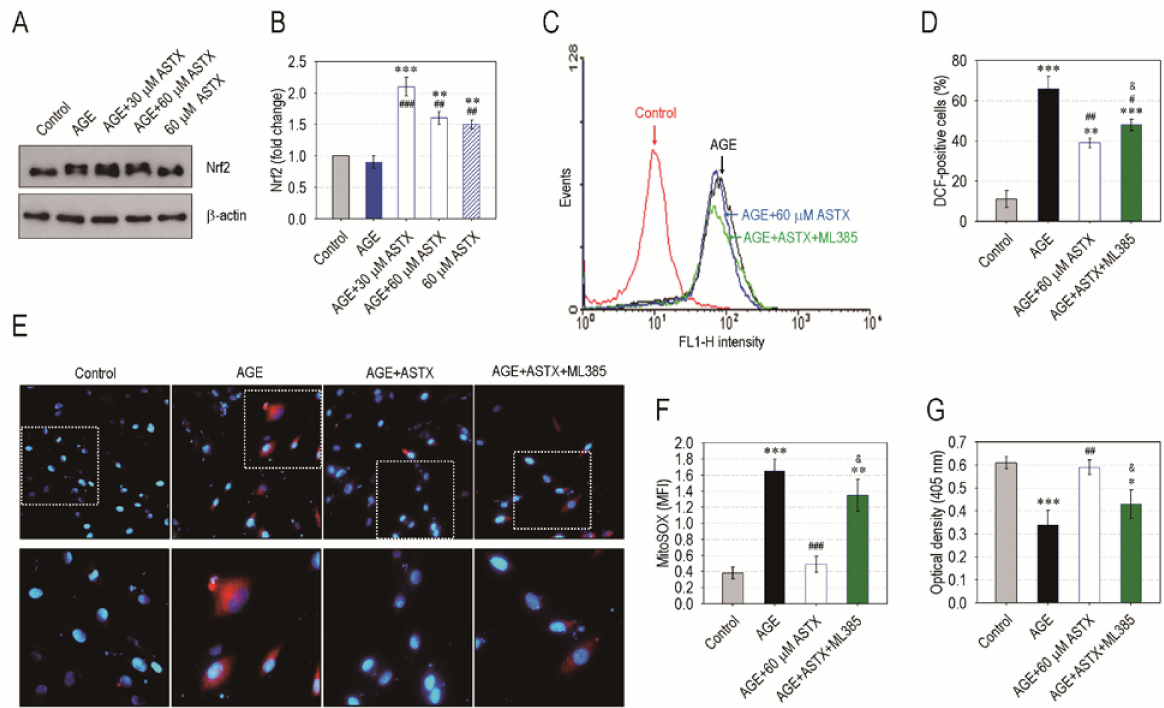
Figure 8. ASTX inhibits oxidative stress and increases proliferation in AGE-exposed hPDLCs by upregulating Nrf2 pathway. The hPDLCs were incubated in growth medium supplemented with and without AGE (200 µ g/mL), ASTX (30 or 60 µ M), or both. ( A ) After 48 h of incubation, the protein level of Nrf2 in the cells was determined by immunoblot assay, and ( B ) the Nrf2-specific band intensity (fold change to control) was calculated after normalizing its level to that of β -actin ( n = 4). The hPDLCs were also exposed to AGE, ASTX, or both with and without the pretreatment with 5 µ M ML385. After 48 h of incubation, ( C ) the DCF-specific signal and ( D ) the DCF-positive cells (%) in the hPDLCs were calculated by flow cytometry ( n = 5). After the same time, ( E ) immunofluorescence assay was also performed using MitoSOX Red and DAPI, and ( F ) the red dye-specific MFI among the experiments was compared after calculating the levels using ImageJ software ( n = 5). ( G ) In addition, proliferation rate of the cells was determined at the end of 48 h incubation using a CCK-8 assay kit. * p < 0.05, ** p < 0.01, and *** p < 0.001 vs. the untreated control hPDLCs. # p < 0.05, ## p < 0.01, and ### p < 0.001 vs. the hPDLCs exposed to AGE alone. & p < 0.05 vs. the cells exposed to ASTX in combination with